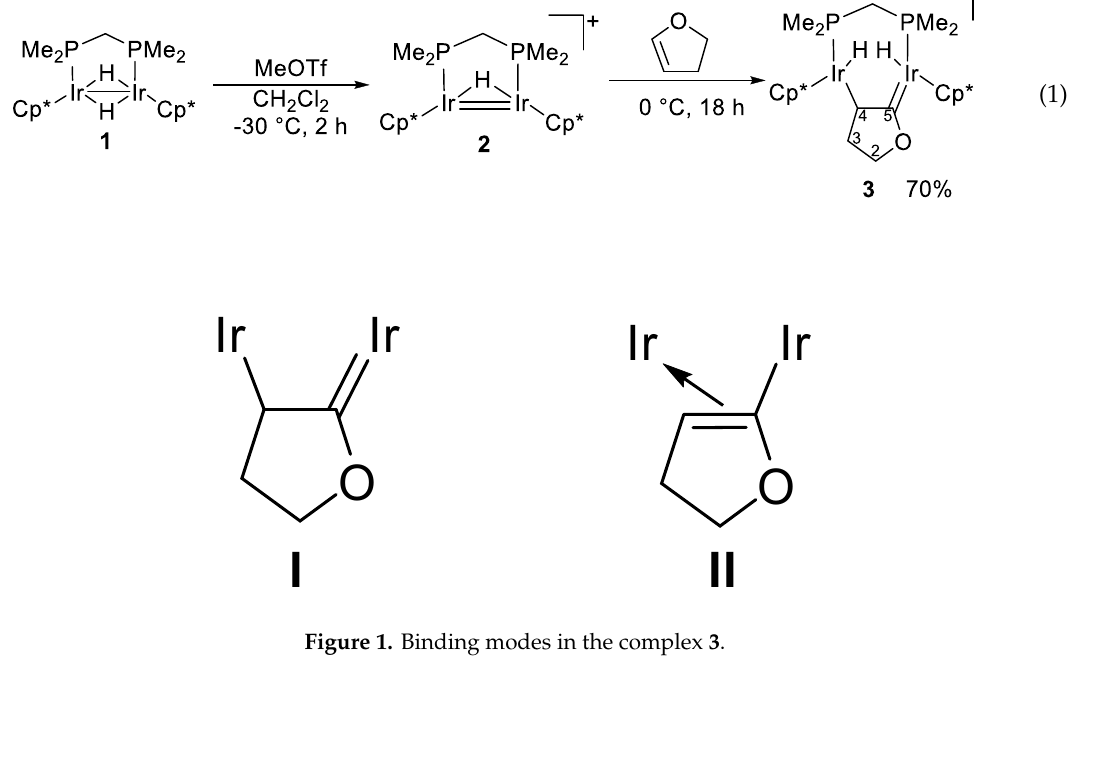
Figure 2. ORTEP drawing of the cationic part of 3 . Hydrogen atoms are omitted for clarity.